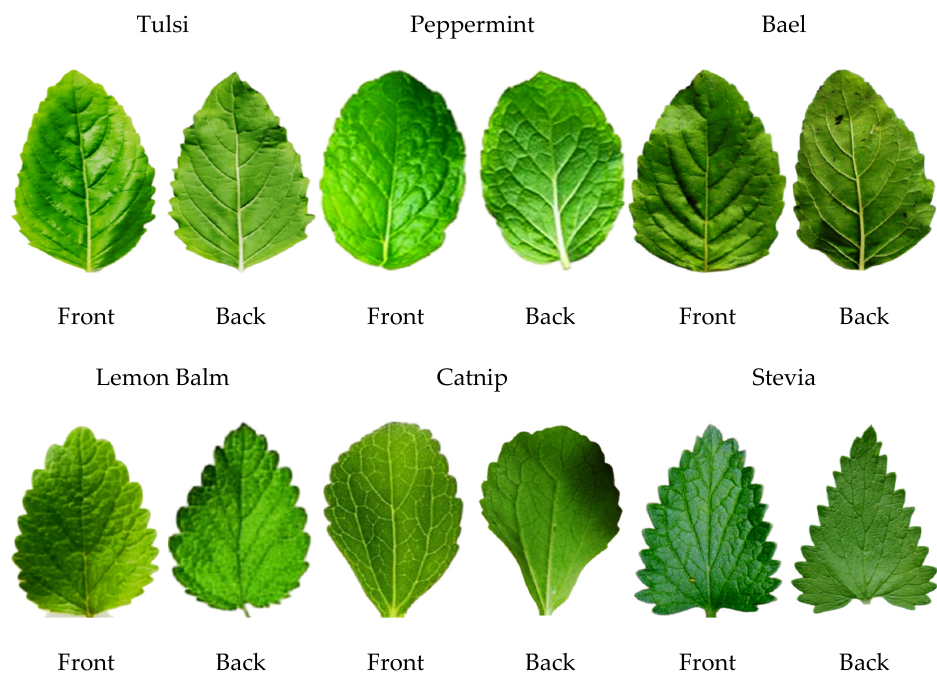
Figure 1. Sample of the medicinal plants leaves belonging to the dataset.